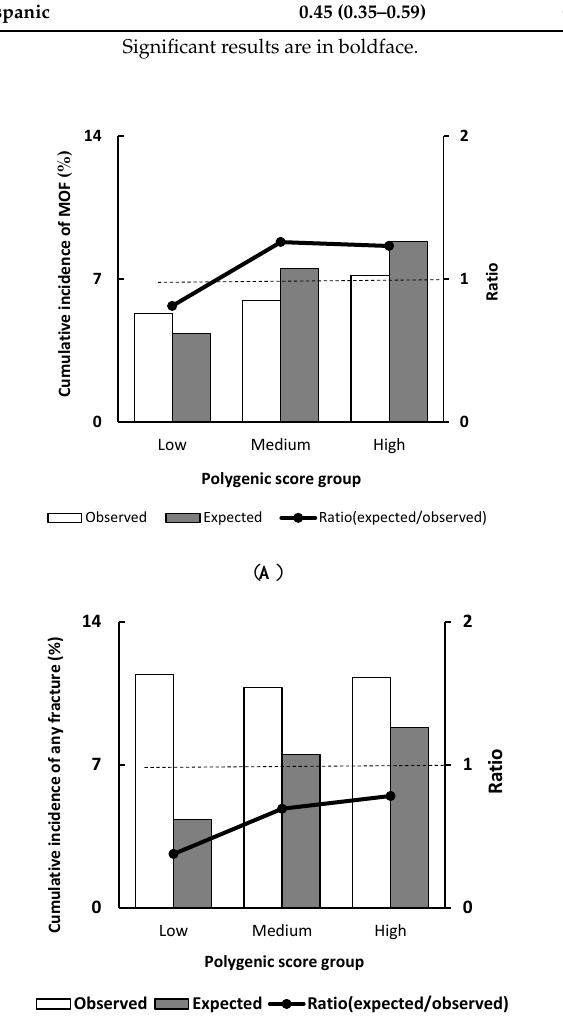
Figure A1. Observed versus predicted major osteoporotic fracture (A) and any fracture (B) stratified by polygenic score group, 10 years of follow-up. The dotted line indicates a relative ratio of 1 (reference line); ratio <1 indicates that T-score underestimates fracture risk.